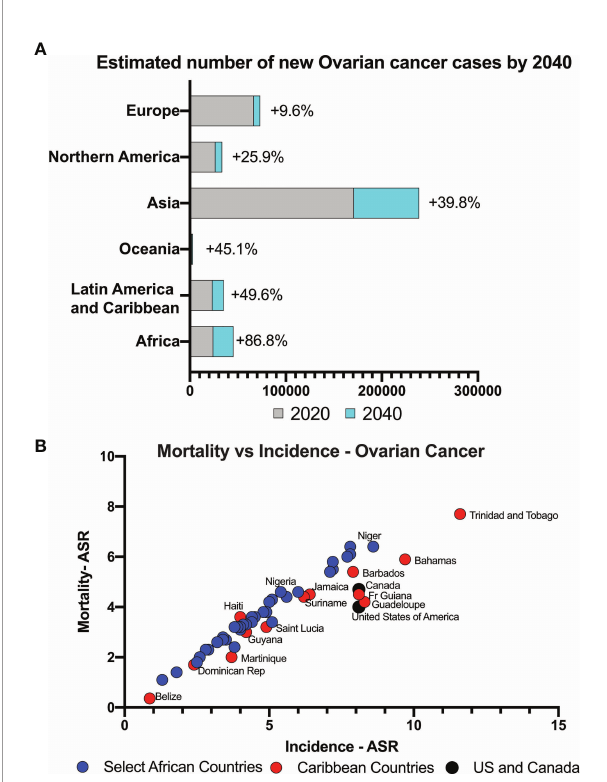
FIGURE 1 | (A) Estimated number of ovarian cancer cases expected globally. Low- and middle-income countries expect to see signi fi cant increase in newly diagnosed cases. (B) Mortality versus incidence rates of ovarian cancer in countries with majority Black women compared to USA and